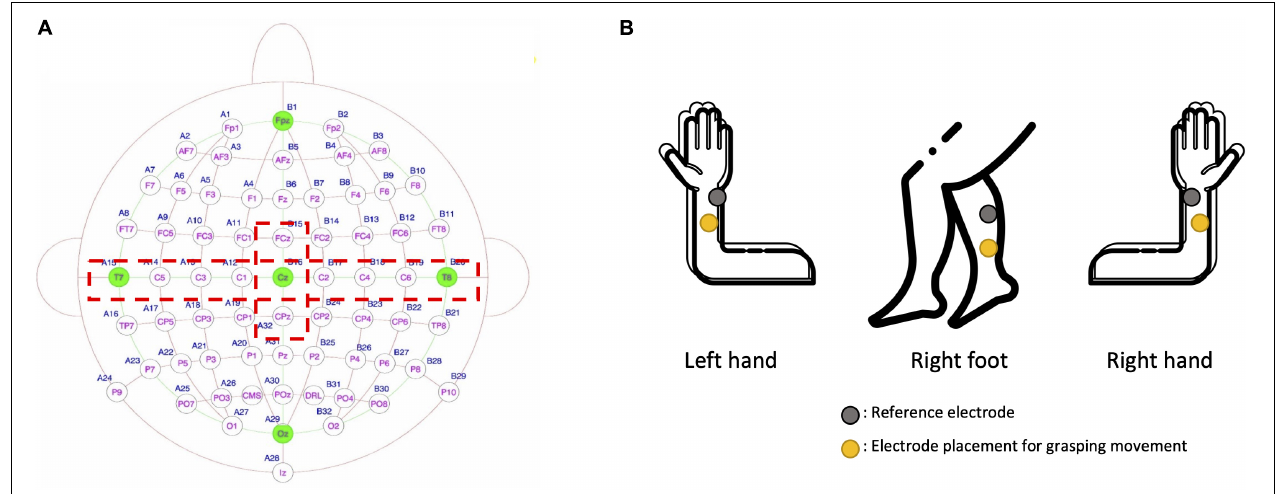
FIGURE 4 | (A) Eleven electrode positions (red dotted lines) were used for electroencephalogram analysis. (B) Shown are electrode positions of the three channels in the electromyogram that were used to control by neuro-feedback the force and speed of movements (i.e., left hand, right hand, and right